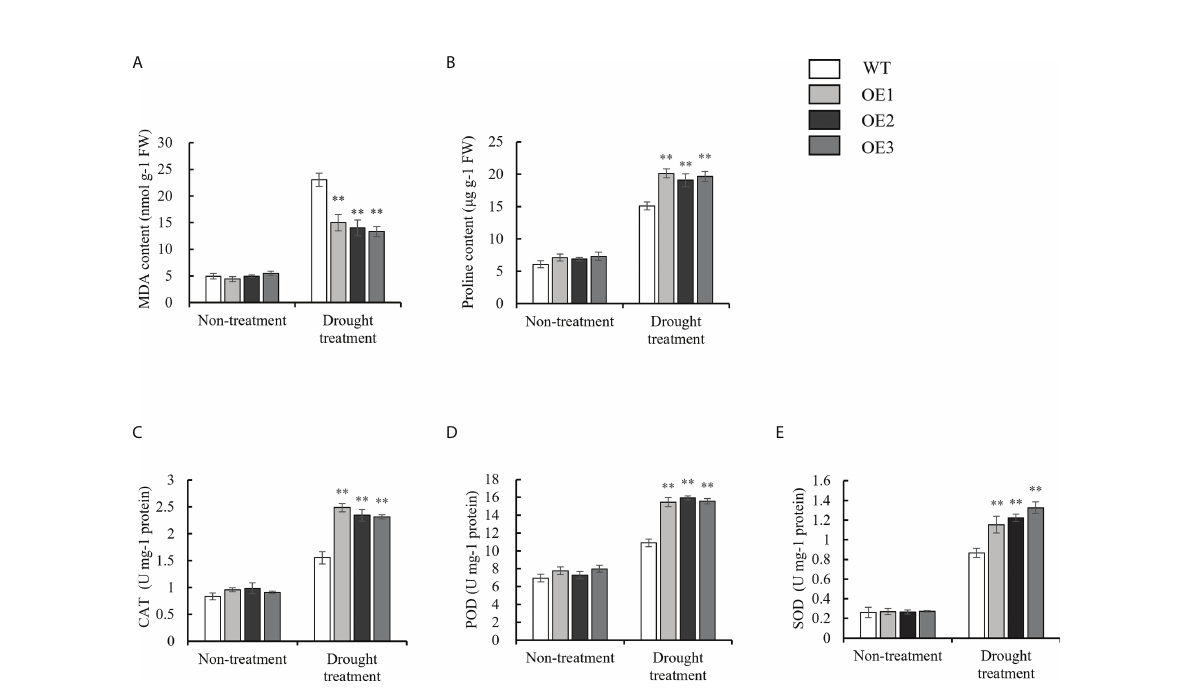
FIGURE 6 Evaluation of physiological indices of OE lines and WT responsive to drought stress. (A) MDA content. (B) Proline content. (C-E) Alterations of Activities of CAT, POD, and SOD. Standard deviations are indicated by error bars (mean ± SD and n = 3). Student ’ s t-test was used to calculate signi fi cance: ** indicates p >